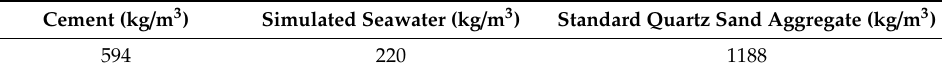
Table 1. Mix proportions of the chloride-contaminated concrete mixture.